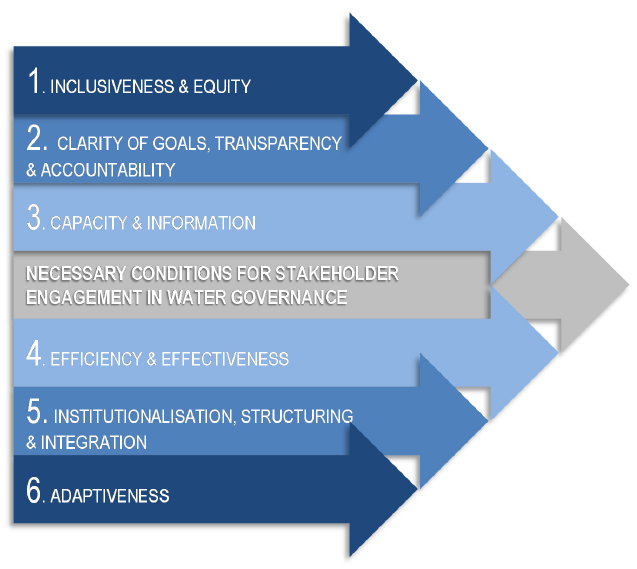
Figure 5. Necessary conditions for stakeholder engagement in water governance [23].